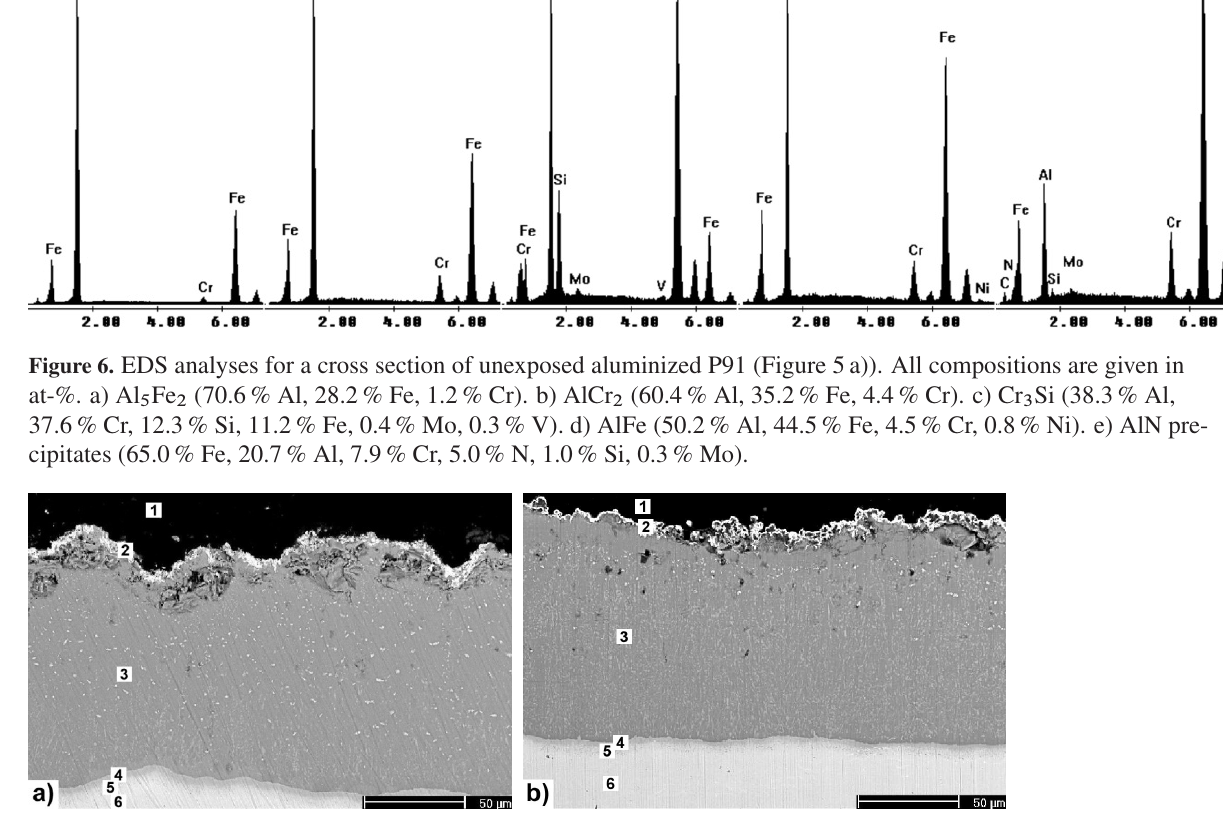
Figure 7. Back scattered electron images showing cross sections of unexposed aluminized specimens. a) P91. b) HCM12A. On both images: 1) Mounting. 2) Nickel coating. 3) Al 5 Fe 2 matrix phase (as grey in images) with AlCr 2 and Cr 3 Si precipitate phases (both as white in images, with the latter shown slightly brighter). 4) AlFe phase. 5) AlN precipitates. 6)